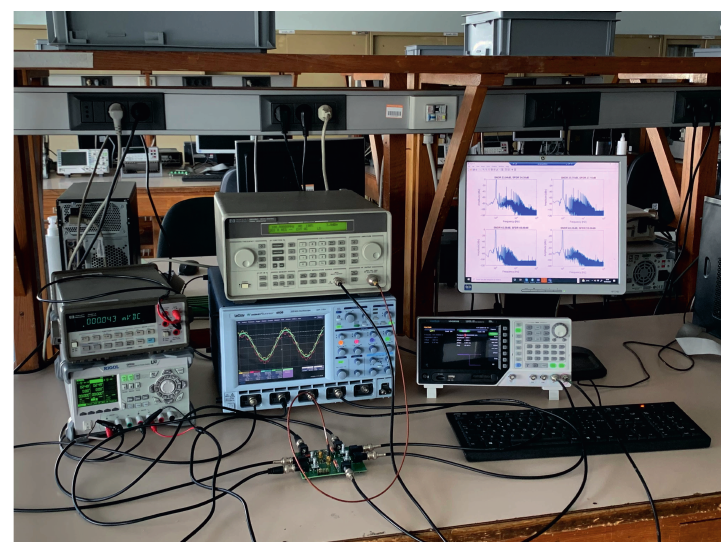
Figure 5. Photograph of the experimental test bench.